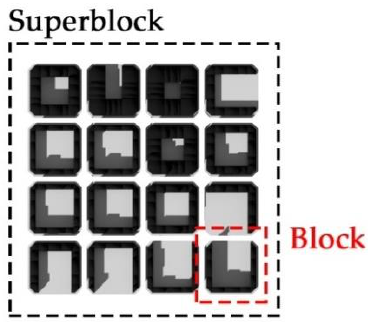
Figure 3. A superblock is composed of 16 blocks arranged in a square grid (4 × 4).